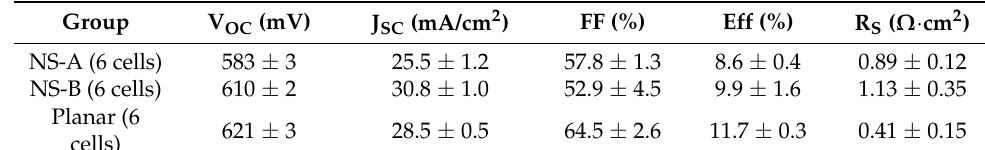
Table 2. Electrical parameters for the silicon nanostructure-textured solar cells. Group